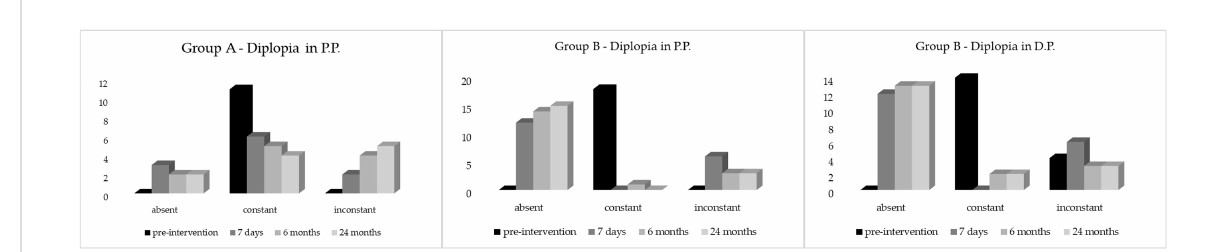
FIGURE 3 Trend of diplopia at four time points. Changes in diplopia from baseline (pre-surgery), up to 24 months ’ follow-up in the two groups (Group A on the left and Group B in the middle and on the right). P.P.: Primary Position; D.P. Down-Gaze Position;